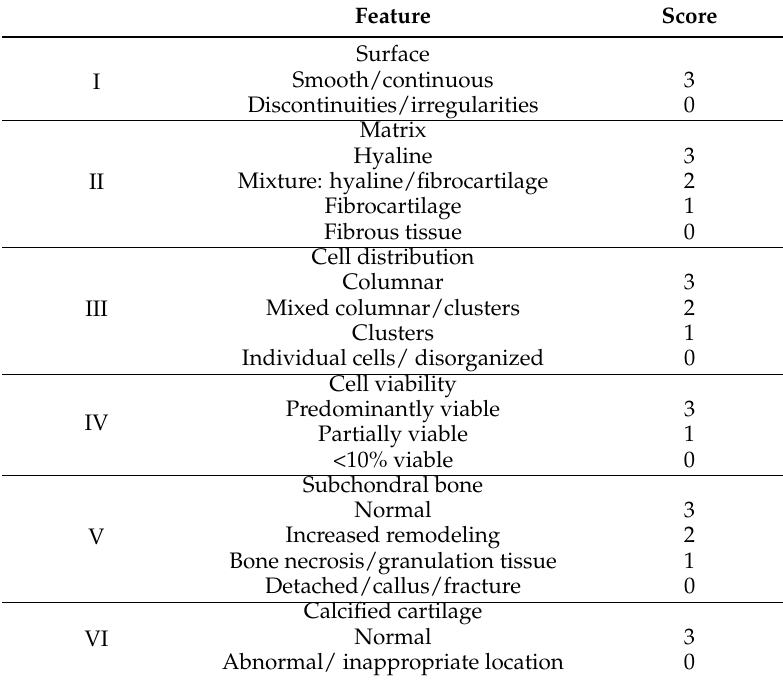
Table 3. The ICRS 1 histological scale.